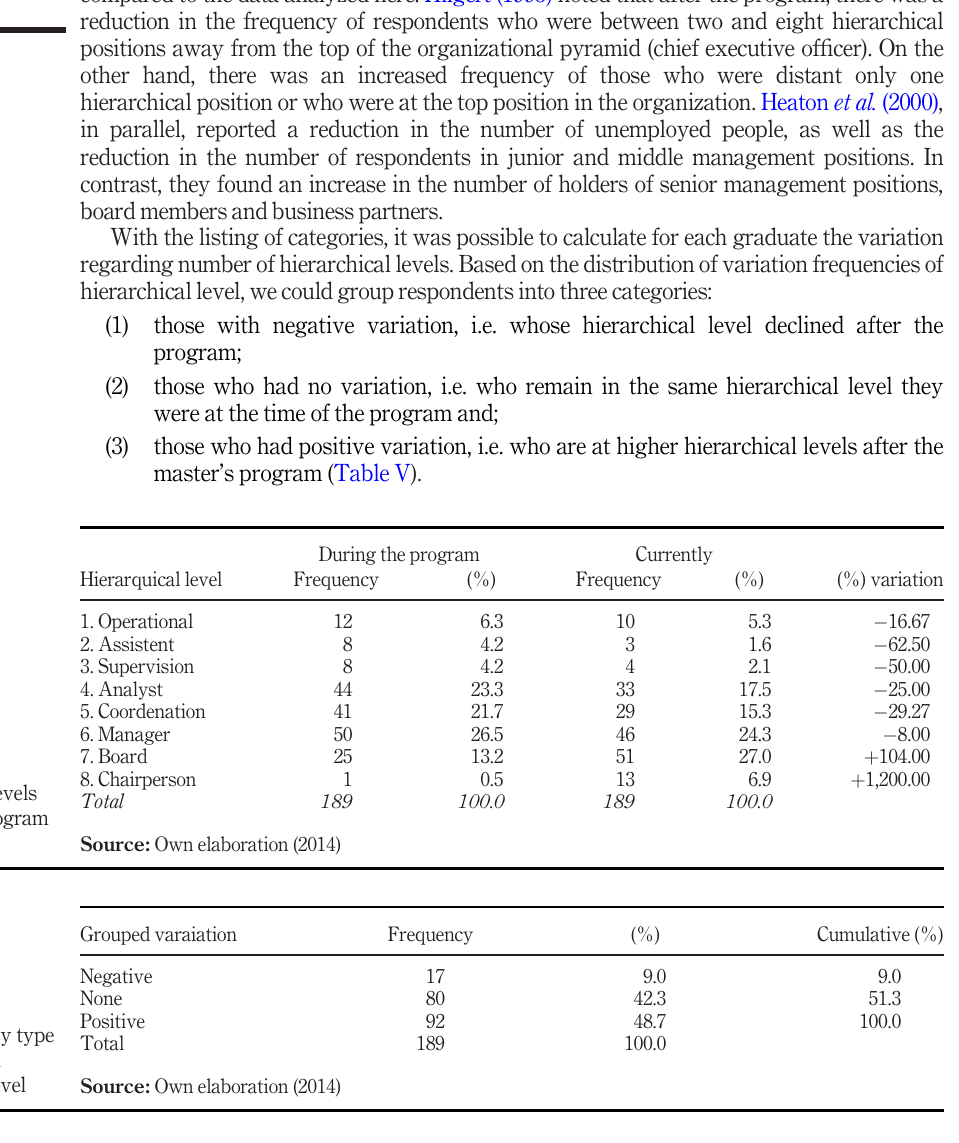
Table V. Grouping of respondents by type of variation in hierarchical level